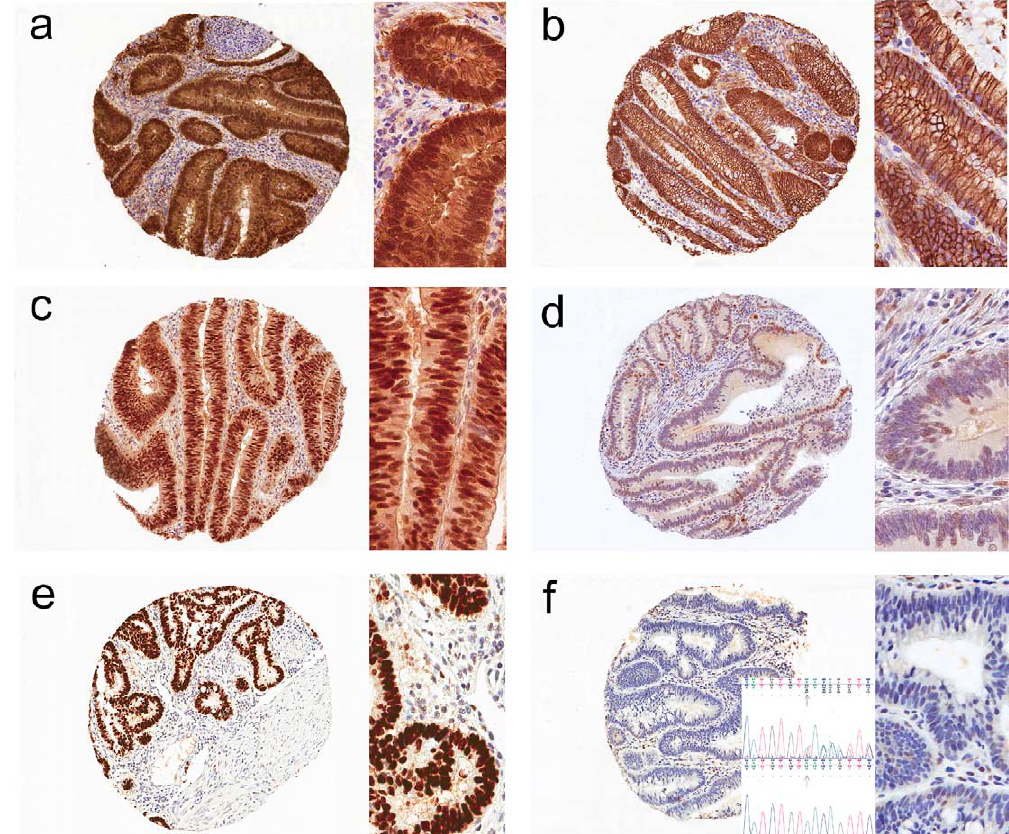
Fig. 2. Images illustrating immunohistochemical expression profiles of β -catenin (a, b), cyclin D1 (c, d) and p53 (e, f). Magnification 100 × and 400 × . Sample (a) shows a nuclear expression of β -catenin and sample (b) a membranous staining pattern. Sample (c) demonstrates an increased expression of cyclin D1, whereas sample (d) shows a negative expression of cyclin D1. Sample (e) shows an increased expression of p53 and sample (f) a negative p53 staining pattern. The negative staining in (f) is caused by a stop codon mutation in dysplastic mucosa, see insert. The upper panel shows the dysplastic lesion with the arrow indicating the insertion causing the stop codon mutation. The lower panel shows the normal